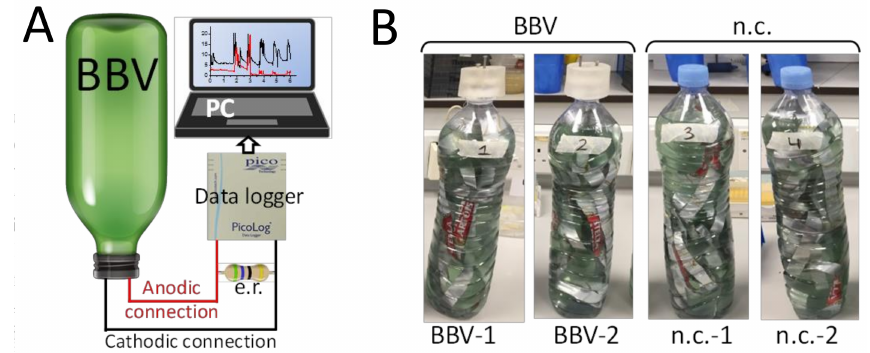
Figure 2. The experimental setup. ( A ) Schematic view of the experimental setup. The potential (mV) anode-to-cathode of the Bio-Bottle-Voltaic systems was measured by a data logger and recorded by a PC. An external resistor (e.r.) was placed in parallel with the data logger. ( B ) The experimental setup included two BBV systems (BBV-1 and BBV-2) and two unwired bottles as negative control (n.c-1 and